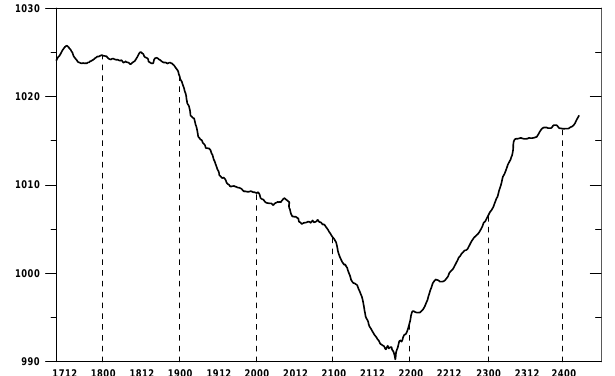
Fig. 2. Surface Pressure (hPa) evolution as recorded at the Palma station for the period from 17 to 24December1979. Date labels are presented in DDHH format. Dashed lines show midnight